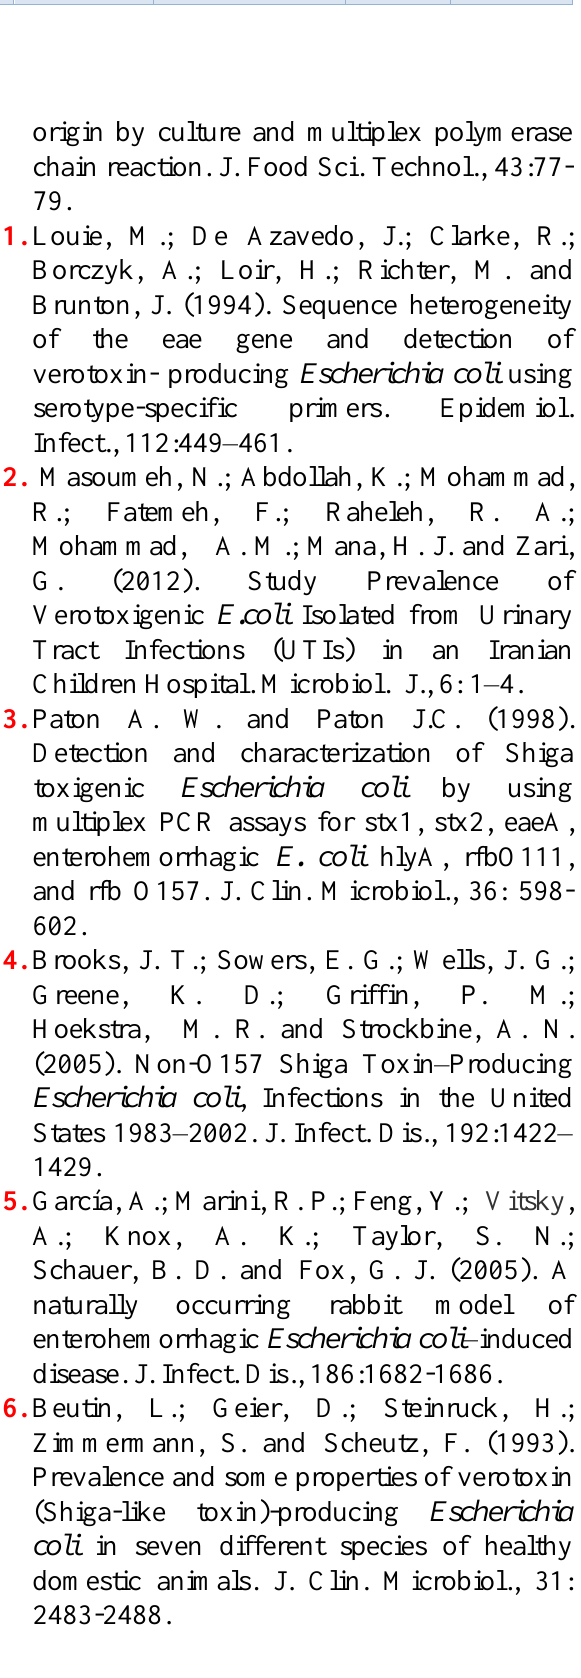
Table, 3: Showed results of PCR assay to confirm diagnosis of E.coli O157:H7 No. of